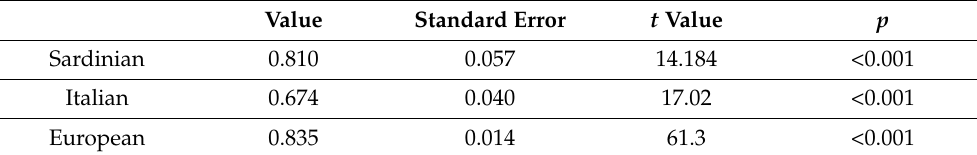
Table 4. Comparison between the contributions of N0 values in the children’s age based on different regression models. Value Standard Error t Value p Sardinian 0.810 0.057 14.184 <0.001 Italian 0.674 0.040 17.02 <0.001 European 0.835 0.014 61.3